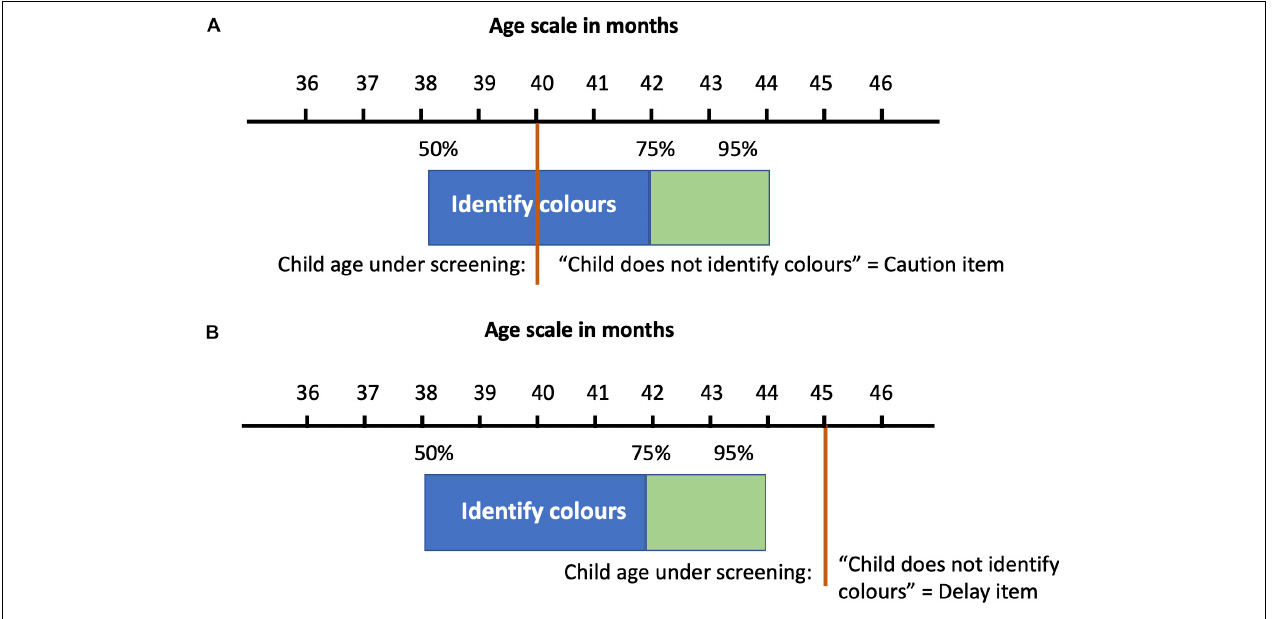
FIGURE 2 | (A,B) Examples of Caution and Delay answers in “Identify colors” item in Haizea-Llevant.